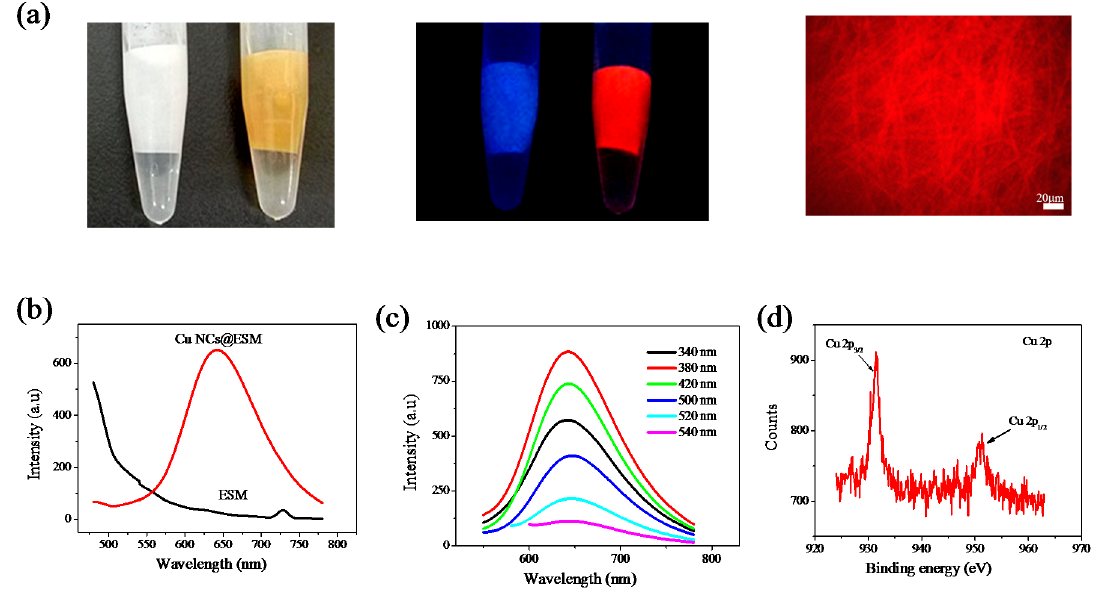
Figure 3. Photos and spectra of Cu NCs@ESM by VC reduction under alkaline condition. ( a ) Photos of obtained Cu NCs@ESM under room light (left) and 365 nm UV light (middle) along with the fluorescence microscopy image (right); ( b ) Fluorescence emission spectra of Cu NCs@ESM and ESM excited by 365 nm; ( c ) Fluorescence spectra of Cu NCs@ESM by varying excitation wavelengths from 340 to 570 nm; ( d ) XPS spectrum in the Cu 2p region of the resulting Cu NCs@ESM.